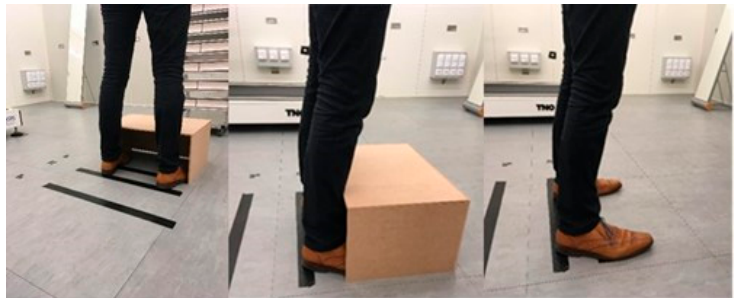
Figure 4. Instructional pictures on methodology for consistent placement of the test person relative to the radiation panel.